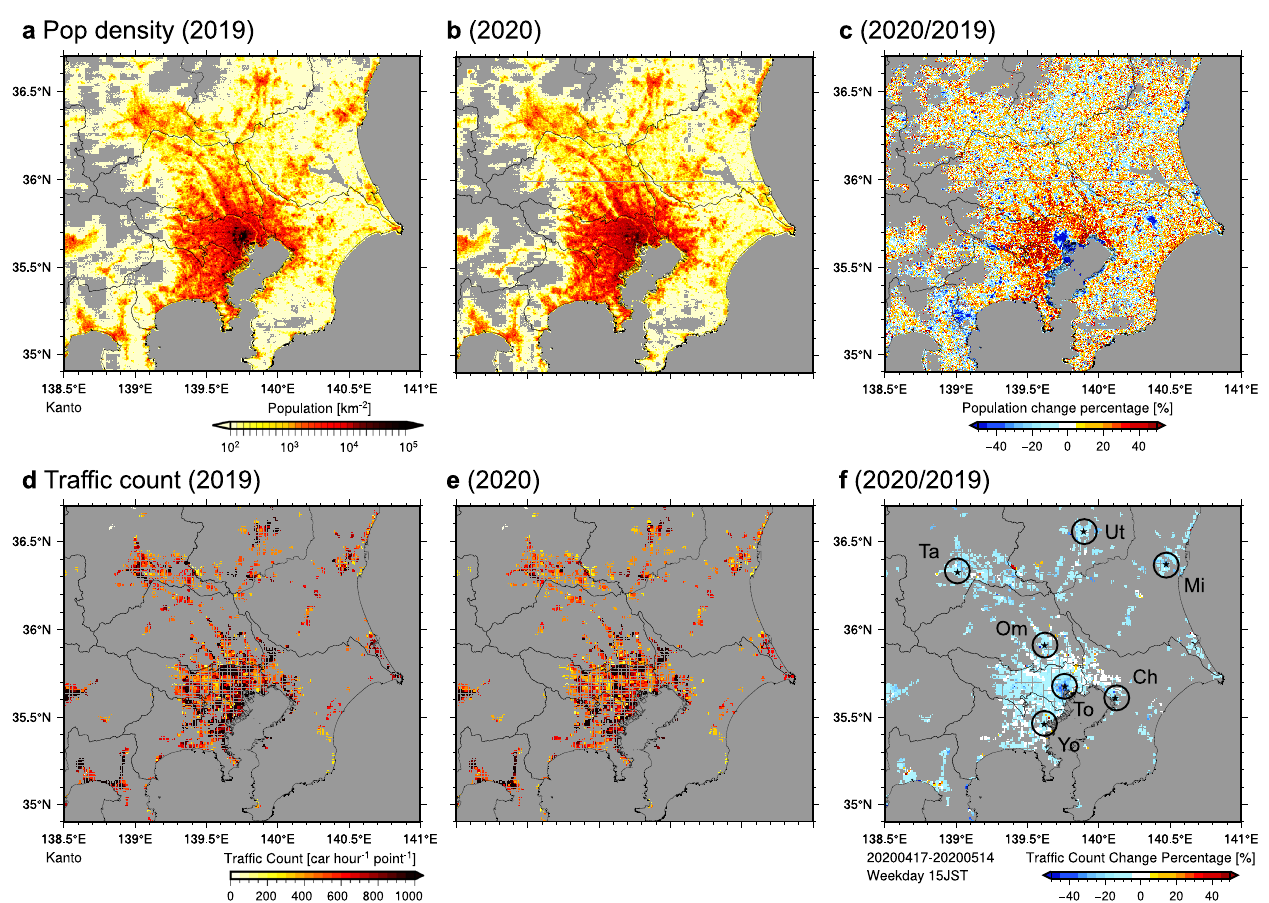
Fig. 1 Changes in human behaviour due to the COVID-19 pandemic. Horizontal variation in population densities (pop km − 2 ) for 15:00 Japan Standard Time (JST) a 18 April to 14 May 2019, b 2020, and c the 2020/2019 change ratio. Traf fi c counts for d 18 April to 14 May 2019, e 2020, and f the 2020/2019 change ratio and site locations of analysed point: To (Tokyo), Yo (Yokohama), Ch (Chiba), Om (Omiya), Mi (Mito), Ta (Takasaki), and Ut (Utsunomiya) on the Kanto Plain including the Tokyo Metropolitan Area